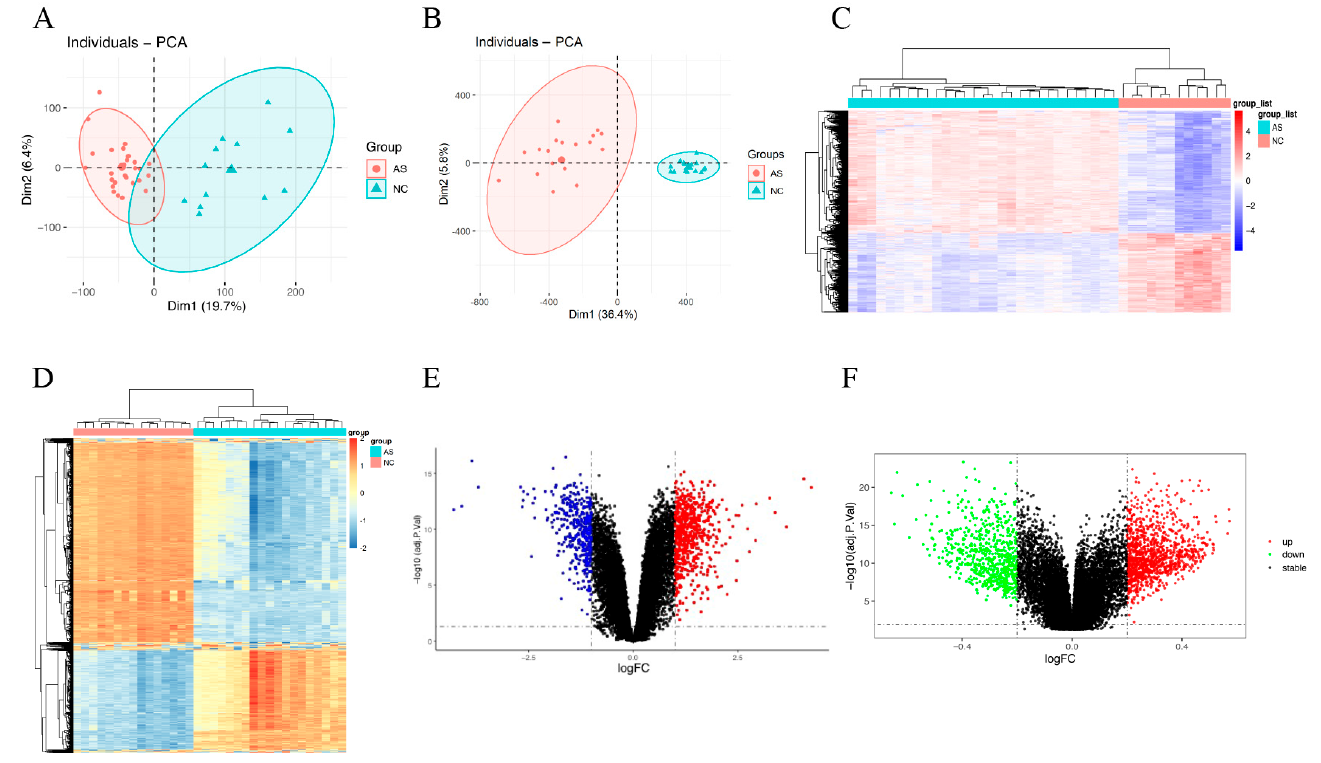
Figure 2. Identification of differentially expressed genes (DEGs) in gene expression profile dataset GSE100927 and differentially methylated genes (DMGs) in DNA methylation profile dataset GSE46401 between normal control arteries (NC) and arteriosclerotic lesions (AS). The cutoff standards for DEGs and DMGs were logFC >1, p < 0.05 and logFC >0.2, p < 0.05, respectively. ( A ) Principal component analysis (PCA) of the sample distribution in GSE100927. ( B ) PCA of the sample distribution in GSE46401. ( C ) Heatmap of DEGs identified in GSE100927. ( D ) Heatmap of DMGs identified in GSE46401. ( E ) Volcano plot of DEGs in GSE100927. ( F ) Volcano plot of DMGs in GSE46401.